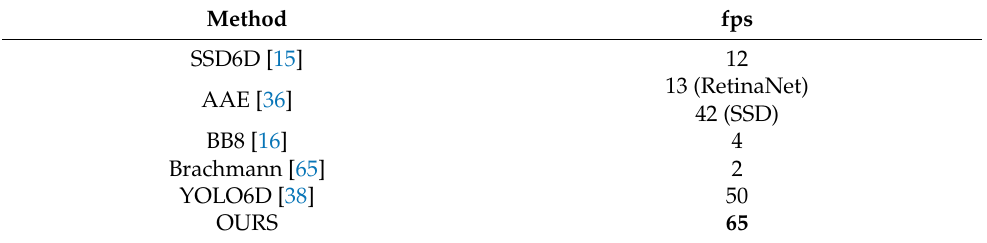
Table 5. Inference time of methods without refinement, according to Reference